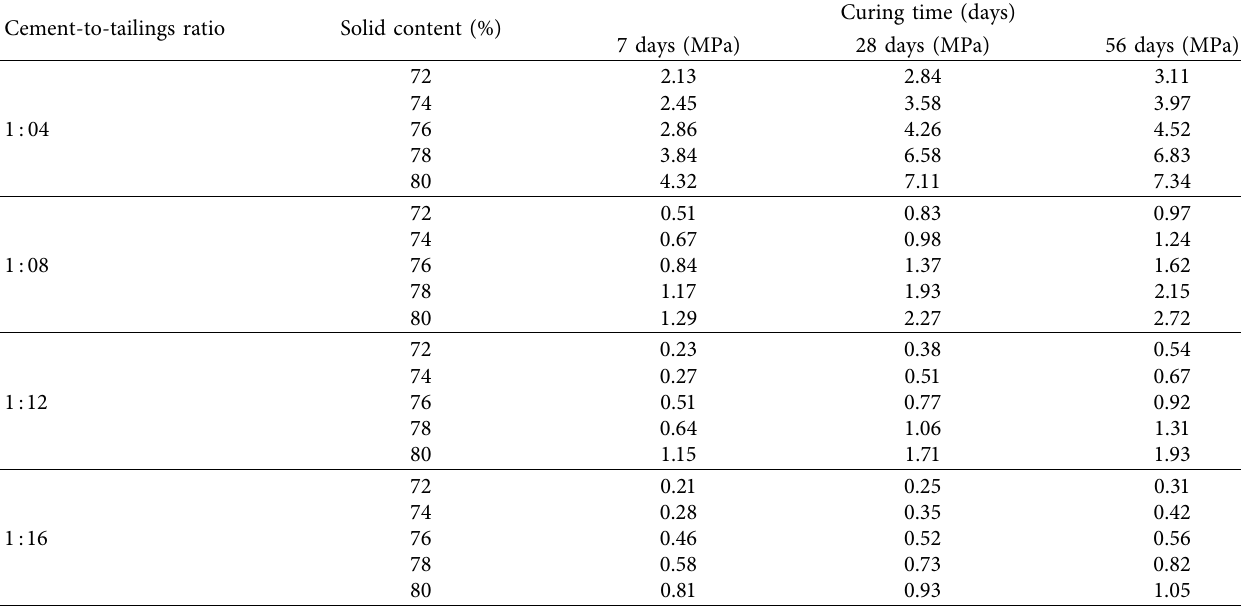
Table 13: The uniaxial compressive strength test results of different CUTB samples. Cement-to-tailings